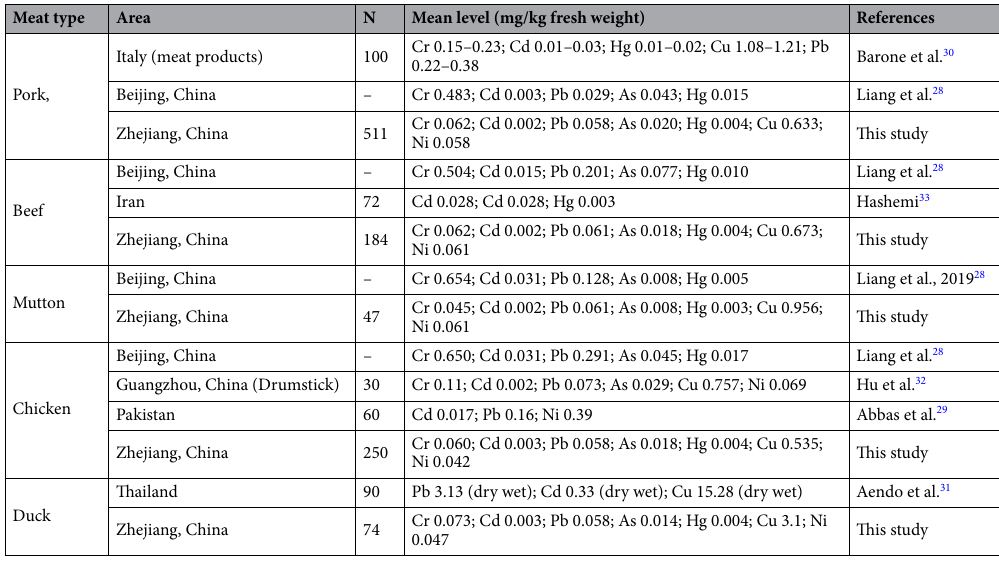
Table 3. Comparison of different metals in meat with some previous